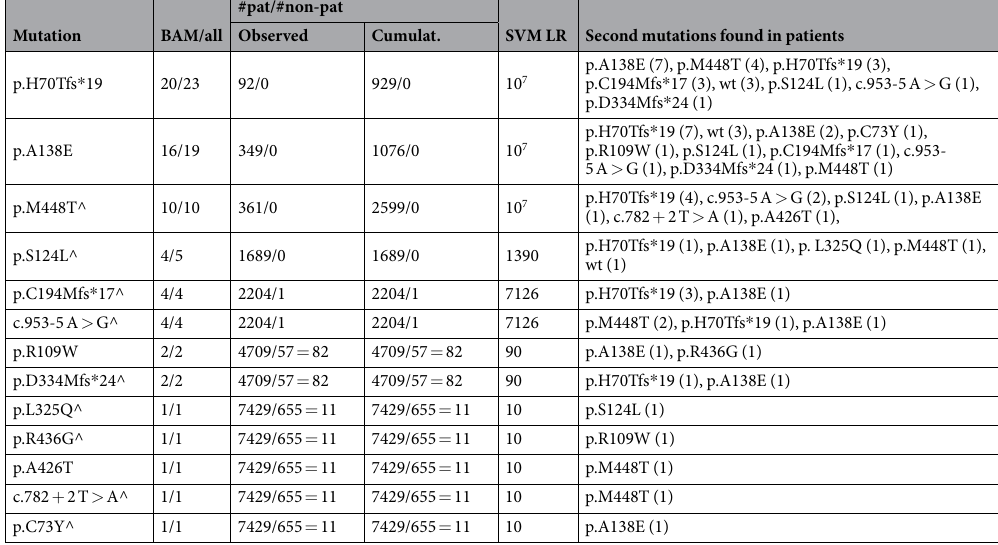
Table 2. Statistical assessment of the disease-association of the detected TMPRSS3 mutations using ISVS Simulator . BAM/all– number with bi-allelic mutations/total number with given mutation. in brackets - number of patients with a given mutation. The settings for ISVS Simulator : number of patients = 2 200; disease prevalence 1/1000; fraction of disease cases explained by mutation in the gene: 0.02; Number of iterations: 10 000; Number of pathogenic mutations: 10; Number of non-pathogenic mutations: 20; Cumulative frequency of non-pathogenic variants: 0.05.